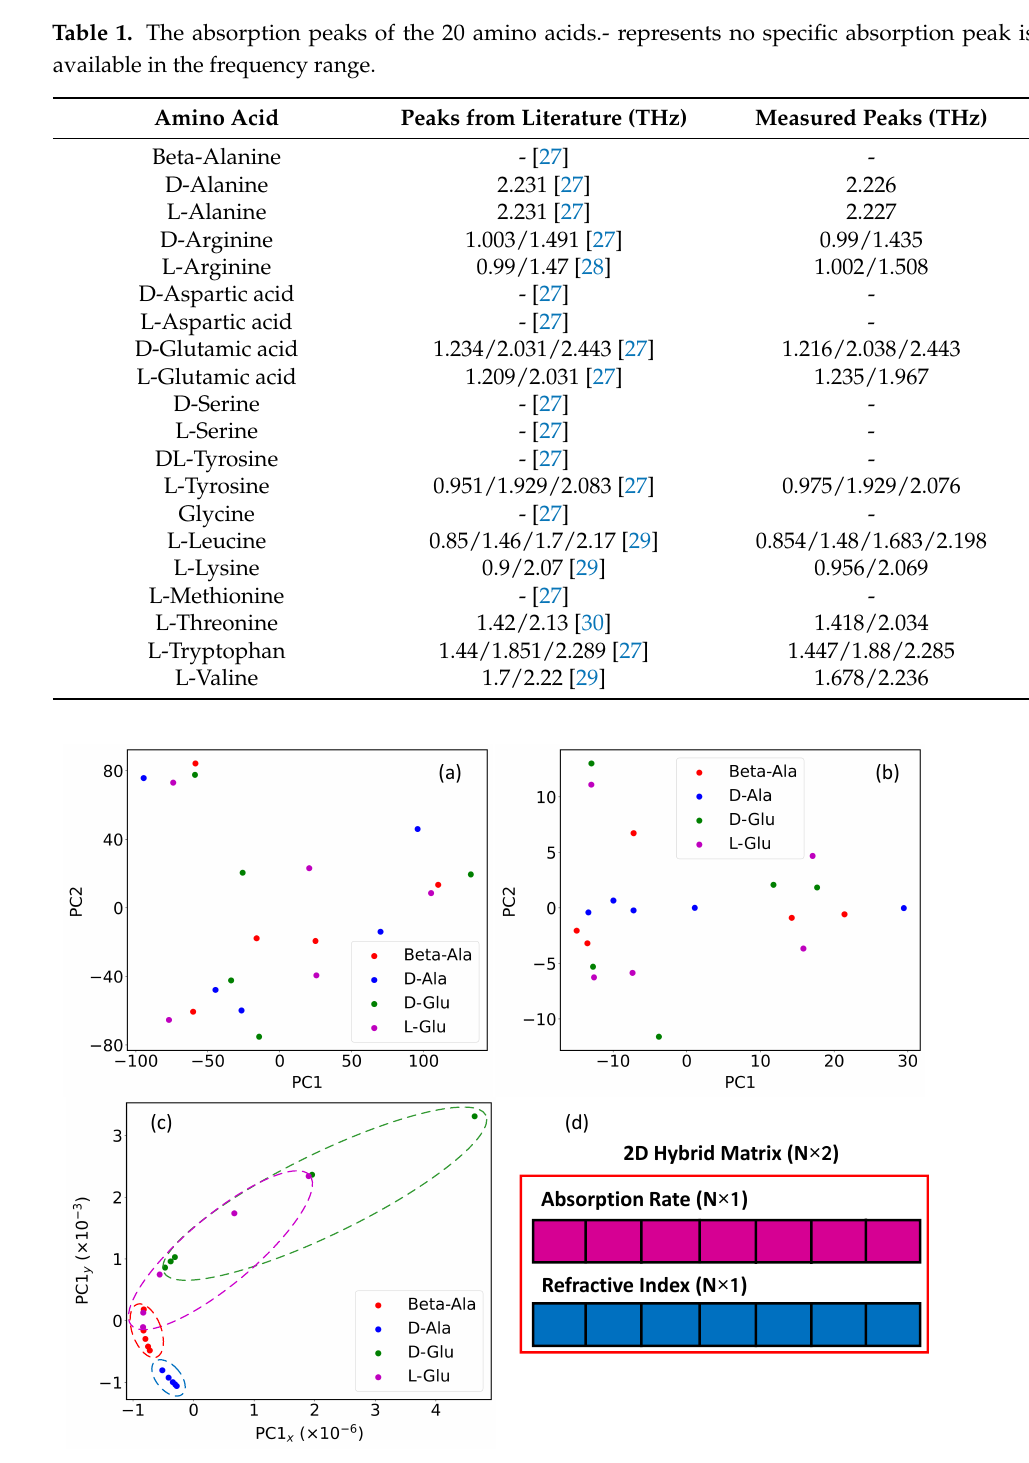
Figure 4. PCA is applied for Beta-Alanine, D-Alanine, D-Glutamic acid, and L-Glutamic acid regarding ( a ) absorption rate, ( b ) refractive index, and ( c ) the 2D hybrid spectrum. Each spot in the graph is generated by averaging the 40 s continuous acquisition of a single tablet. ( d ) illustrates the 2D hybrid spectrum, which is stacked by the absorption rate and refractive index to a N × 2 matrix. N is the size of 1D spectrum, which is 240 in this